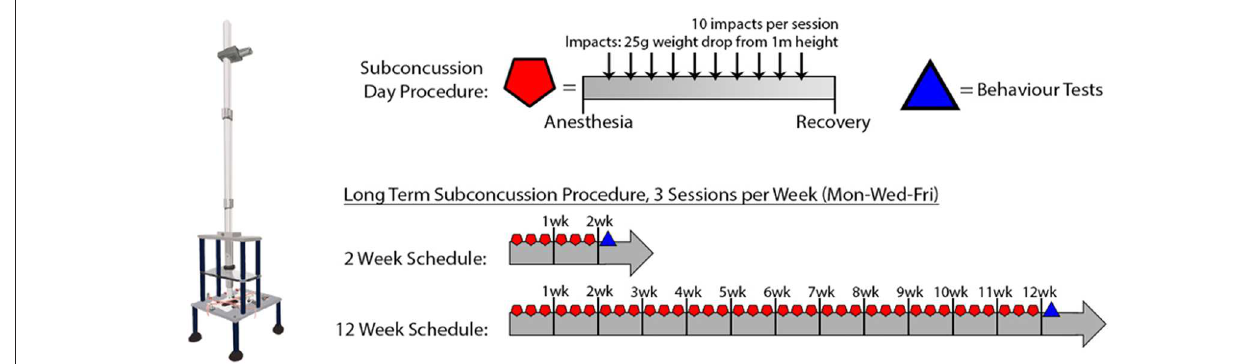
FIGURE 1 | Summary of Sub-concussion Protocol.